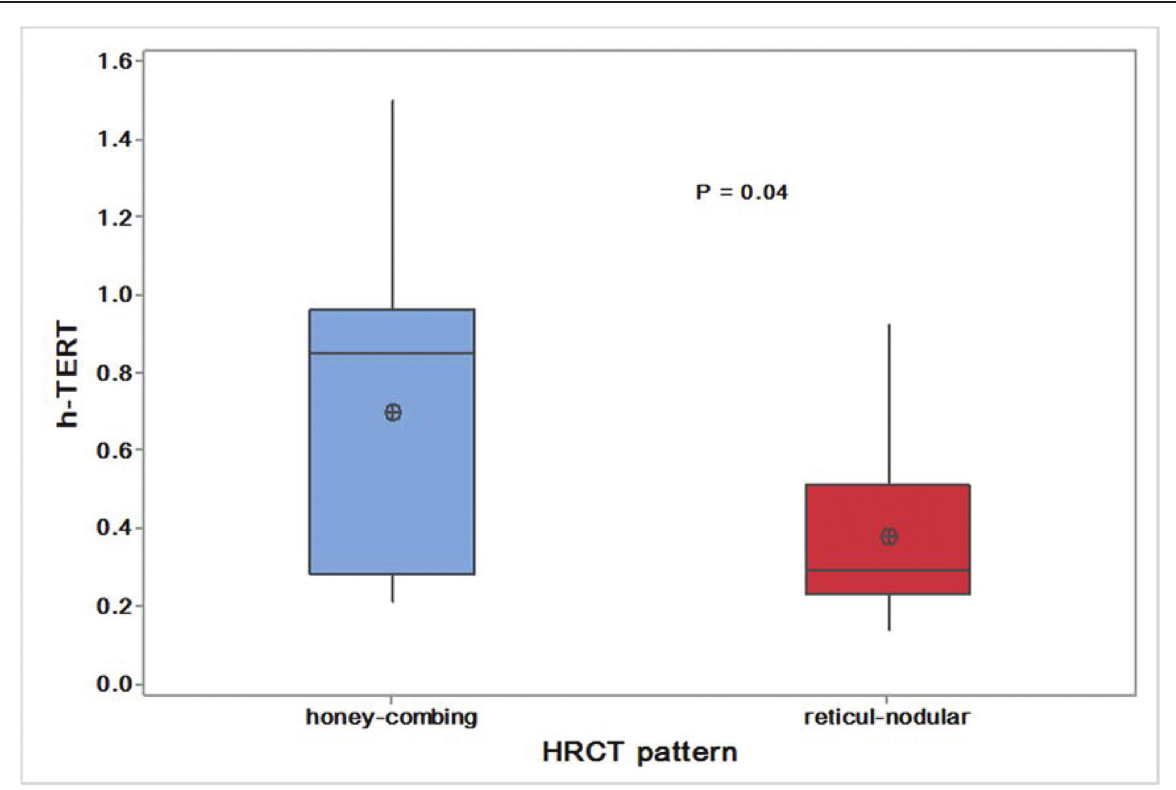
h-TERT expression in IPF patients as regarding its HRCT